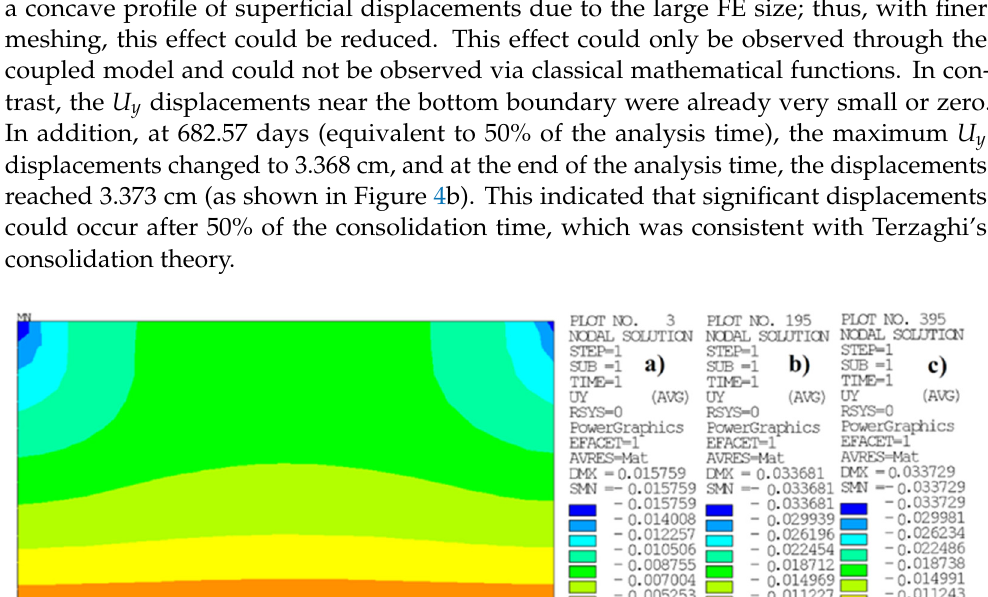
Figure 5. Soil superficial profile of the vertical displacements. Figure 6 shows the finite element mesh of the soil stratum and thus the behavior (elastic and/or plastic) they were under according to the value of the parameter  . When considering this meshing, the behavior of the FEs within the soil stratum could be identi- fied at any time step during the application of the foundation-applied stress. As shown in Figure 6a, for Δt = 13.93 days, 90% of the finite elements within the domain exhibited elas- tic behavior (stress and strain) or blue zones. Over time (as shown in Figure 6b), 75% of the FEs exhibited plastic behavior (red zones), and at the end of the analysis time; i.e., 1379.07 days (as shown in Figure 6c), all FEs exhibited plastic behavior. Because the low permeability impeded the pore pressure dissipation process and due to the lateral re- strictions; i.e., at the bottom and top, the soil was subjected to plastic strains (irreversible) at the end of the consolidation process.